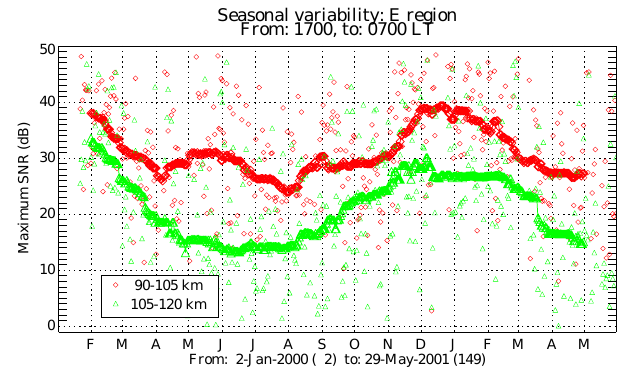
Fig.4. Seasonal variability of maximum daily SNR observed from the lower E-region (red) and the upper E-region (green). The thicker symbols represent 60-day median averages.